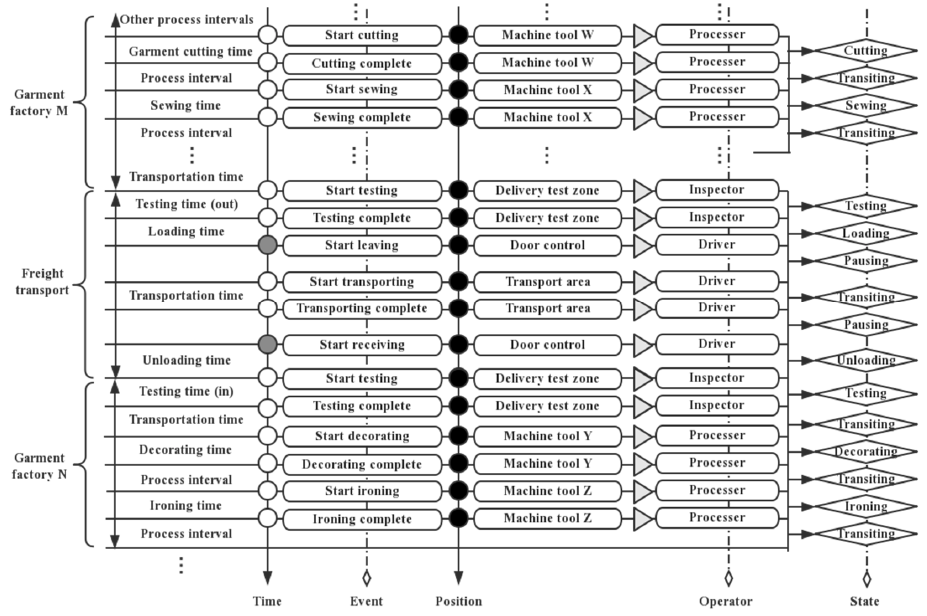
Figure 9. Process flow monitoring diagram based on RFID configuration for garment outsourcing processing.